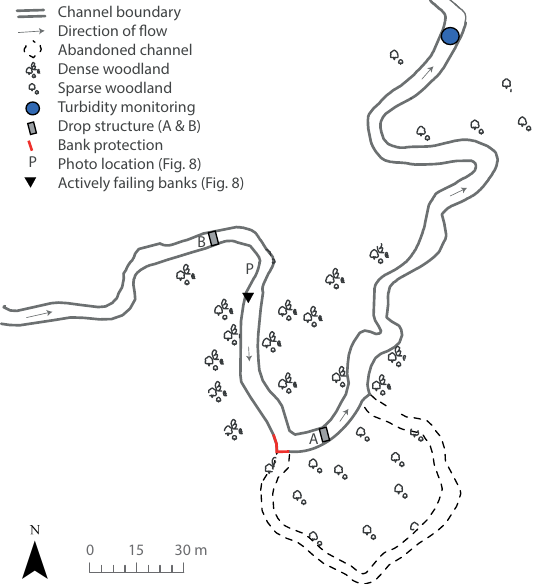
Figure 3. Map showing the diversion location with control mea- sures and monitoring